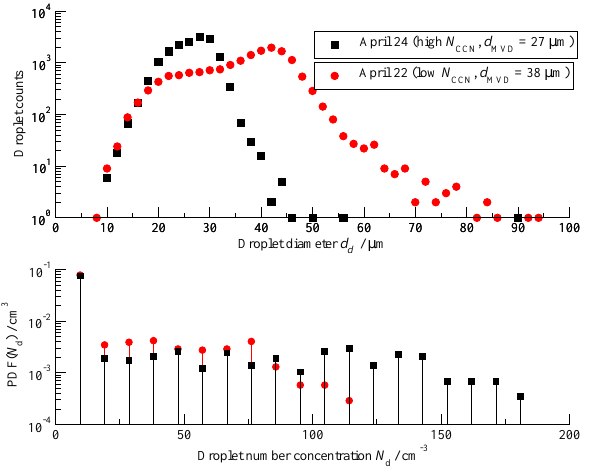
Fig. 11. Droplet size distributions (upper panel) for the cloud re- gions marked in Fig. 10. For both distributions 16000 droplets are considered. The lower panel shows the probability density function (PDF) of droplet number concentrations derived from hot-wire mea- surements.